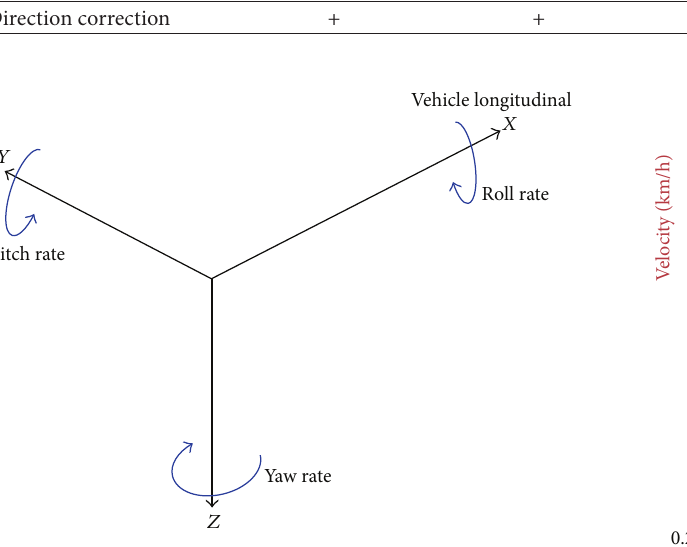
Figure 3: IMU02 coordinate.